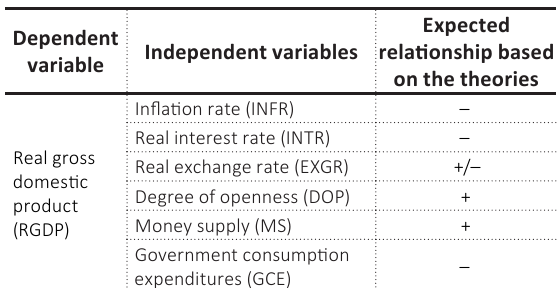
Table 1. Variables used and expected signs based on the